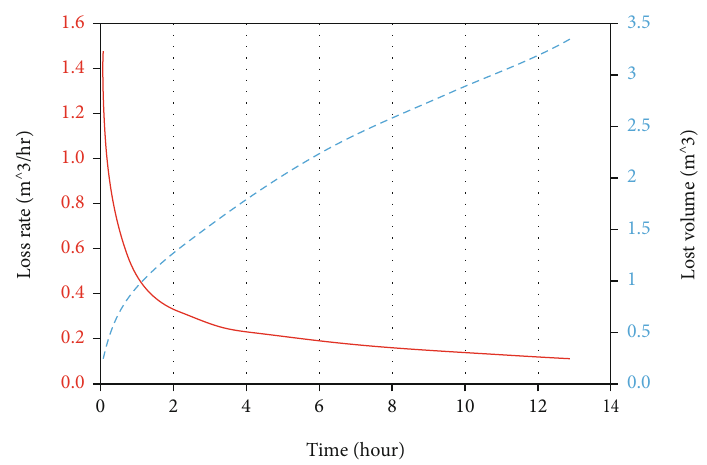
Figure 7: The trends of loss rate and cumulative volume for seepage type of lost circulation.